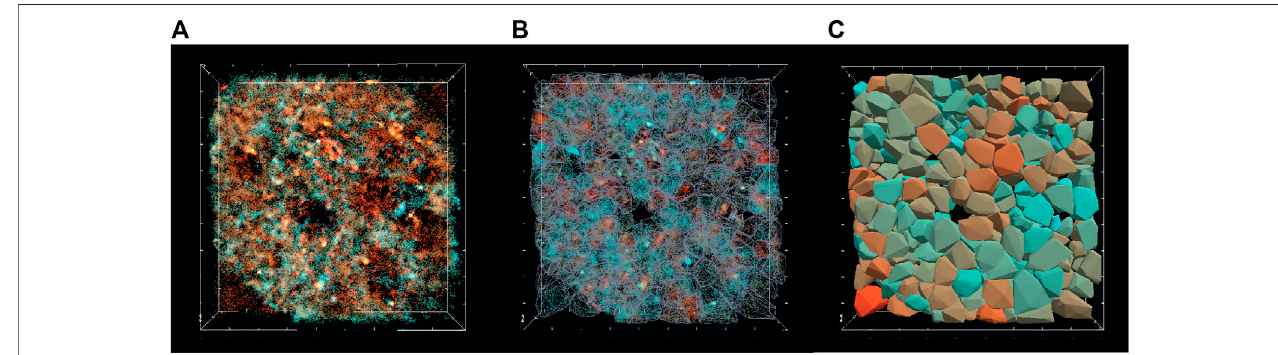
FIGURE 5| The principle of3D diffusion map analyses. (A) Experimental point cloud data generated from beads injected, imaged in 3D and trackedin the nucleus of aliving cell. The panel shows all the recorded localizations color coded by the axial position. (B) A 3D mesh allows identifying different regions with asuf fi cient number of point clouds to perform the analysis. (C) in each region, the diffusion coef fi cient is inferred and shown as a closed surface color coded by the diffusion coef fi